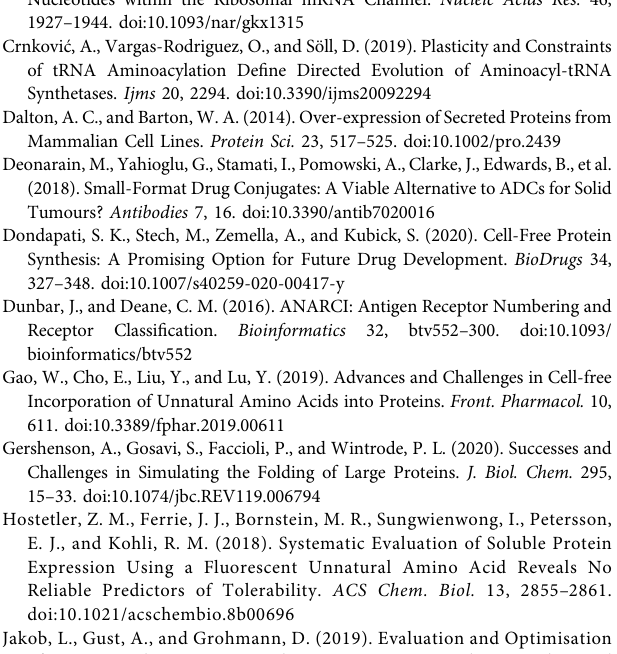
Supplementary Figure S1 | Autoradiograph and liquid scintillation quanti fi cation of cell-free synthesized reporter proteins in the SN1 fraction. Supplementary Figure S2 | Ratio of GFP and RFP signal of reporter proteins according to sample dilution and volume. Supplementary Figure S3 | RNase addition during cell-free translation of fl uorescent reporter proteins. Supplementary Figure S4 | Autoradiograph of scFv with and without fl uorescent reporter synthesized in SN1 and SN2 fraction. Supplementary Figure S5 | Correlation of liquid scintillation quanti fi cation with fl uorescence.